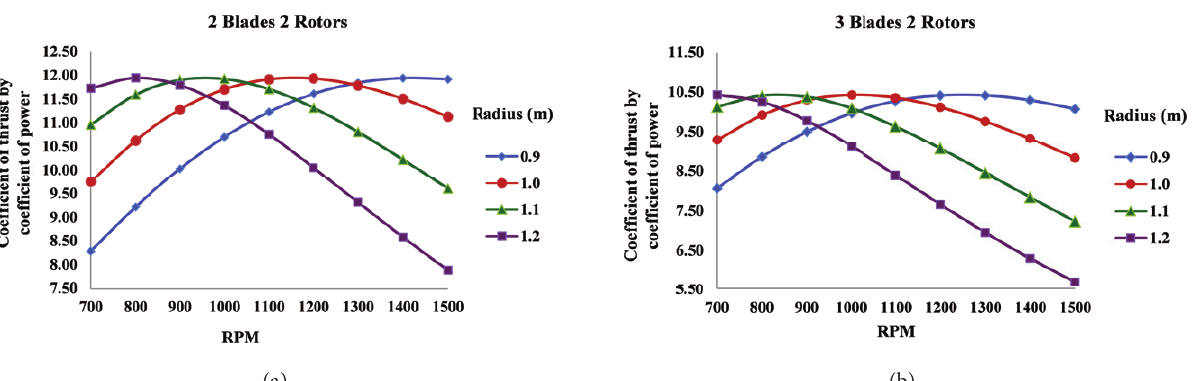
gurations(a) Figure 9. Ratio of coeffi cient of thrust C T , to coeffi cient of power C P , at various n for varying radius for 2-blade 2 rotor and 3-blade 2 rotor confi